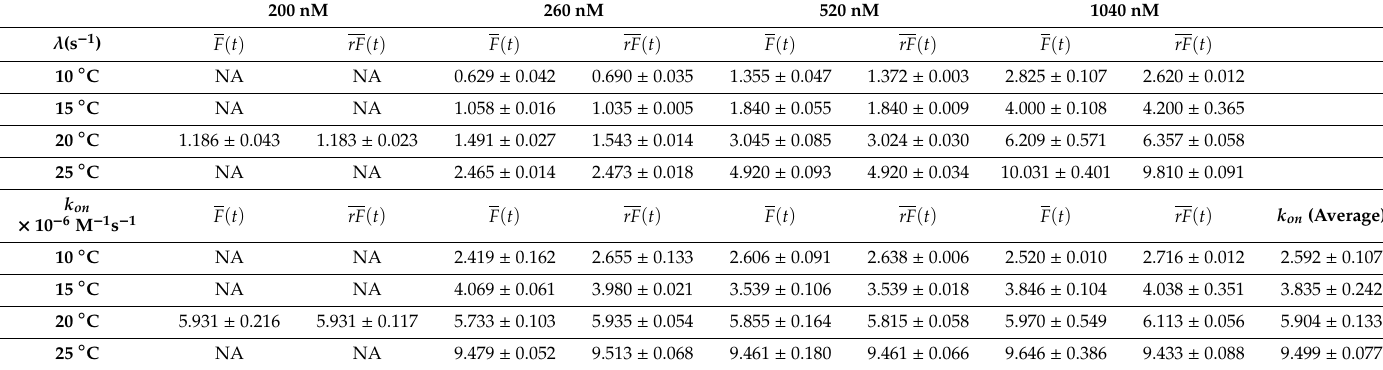
Table 4. Fitted eigenvalues ( λ ) and association rate constants ( k on ) of AV-BcO as a function of concentration and temperature, at pH 8, and under pseudo-first-order conditions.